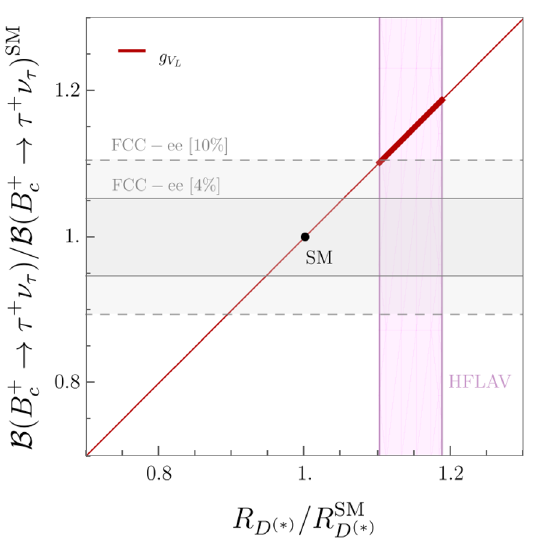
are plotted against the ratio B ( B + /R SM → τ + ν τ ) / B ( B + → D ( ∗ ) c c D ( ∗ ) . The thick lines correspond to the values of L data [72]. The magenta shaded τ and R exp at 1 σ accuracy [23]. The grey /R SM /R SM D D ∗ D D ∗ → c